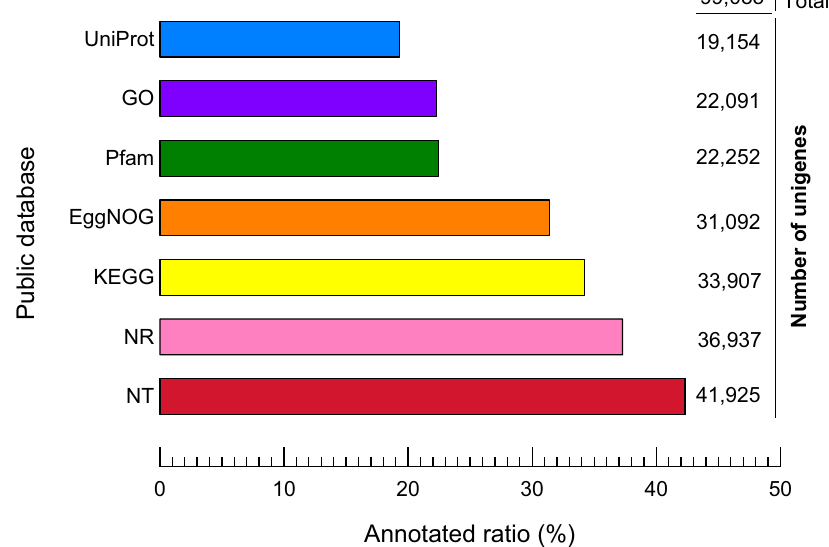
Figure 1. Blasted results for unigenes based on public databases with an E -value default cutoff of E -value 10 –5 . The X axis shows the ratio (%) of annotated unigenes for each database based on total unigenes. The Y axis shows the number of unigenes that are annotated based on each database.